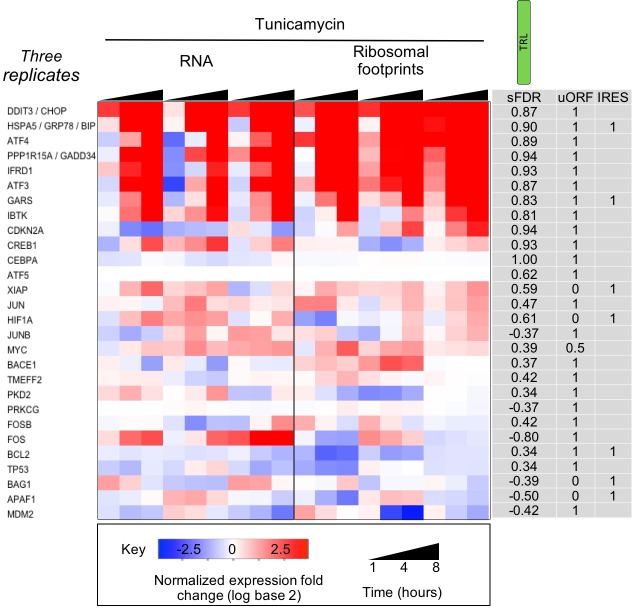
Many uORF and IRES containing genes are translationally regulated.The table/heatmap shows mammalian genes with known translation regulation via upstream open reading frames (uORFs) or internal ribosome entry sites (IRES). The change in expression data is shown for the RNA and ribosome footprinting data for three replicates for ER stress. Eight genes have significant translation upregulation and are shown in the main text. The FDR is listed as the median value across the three replicates (if it is significant it is so in at least two replicates) and converted to a signed value, that is positive if translation regulation is positive and negative if negative. Therefore, values > 0.80 denote an FDR < 0.2 for significant upregulation and values < −0.80 denote significant negative regulation. Figure 2E shows the subset of genes with uORFs and known roles under ER stress. sFDR - signed false discovery rate.